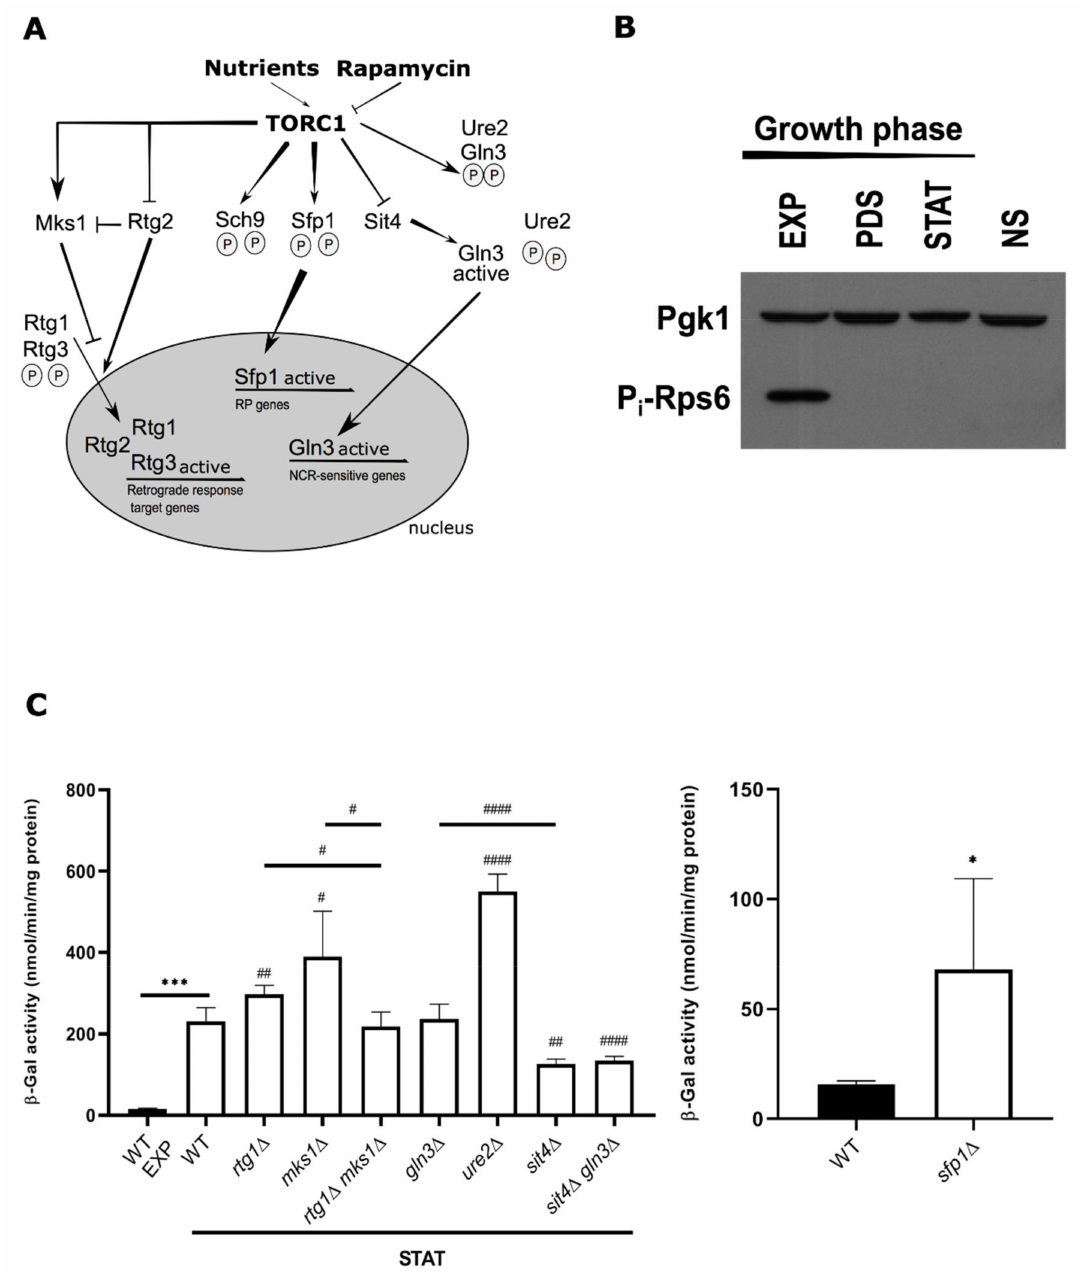
Figure 2. Transcriptional control of DGA1 expression is coupled to cell growth and is mediated by TORC1 downstream effectors Sit4, Sfp1, and Mks1. ( A ) Overview of TORC1-controlled transcriptional program. ( B ) Western blot showing TORC1 activity changes for the indicated periods of growth, as measured by the phosphorylation of bona fide TORC1 target ribosomal protein S6 (Rps6). Pgk1 was used as a loading control. WT cells were grown in SC medium during growth, and aliquots were collected at different growth stages. For the nitrogen starvation experiment (used as internal control), cells were grown in SC medium to exponential phase and shifted to nitrogen-free medium for 90 min. EXP—exponential; PDS—post-diauxic shift; STAT—stationary; NS—nitrogen starvation. ( C ) DGA1 expression is controlled by TORC1-regulated targets Sit4, Mks1, and Sfp1. DGA1 promoter was cloned into the LacZ reporter plasmid YEp357 as described in Section 3 and transformed into the indicated strains. Overnight precultures grown in SC medium lacking uracil were diluted and allowed to grow to reach early stationary phase (left panel, as in Figure 1B), or to exponential phase (right panel). Protein extracts were prepared, and specific β -galactosidase ( β -Gal) activities, with o-nitrophenyl- β -D-galactopyranoside (ONPG) as a substrate, were determined by measuring the amount of o-nitrophenol released by the galactosidase-catalyzed hydrolysis process. Results are mean ± SD of at least three independent experiments. * ,# p ≤ 0.05; ## p ≤ 0.01;*** p ≤ 0.001; #### p ≤